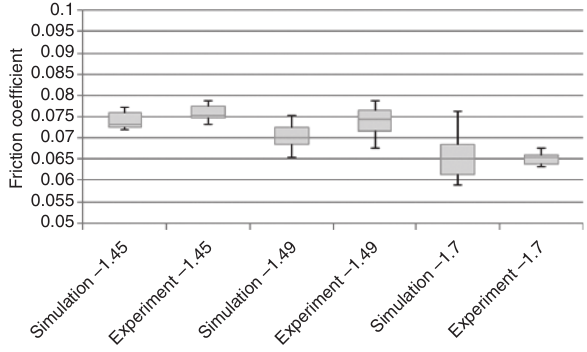
Figure 9: Box plots of simulation and experimental values of SiO and polysilicon contact showing the dispersion range of results, for varied roughness of polysilicon. Boxes denote the range between 1 and 3 quartile, while the whiskers show the range between the minimum and maximum